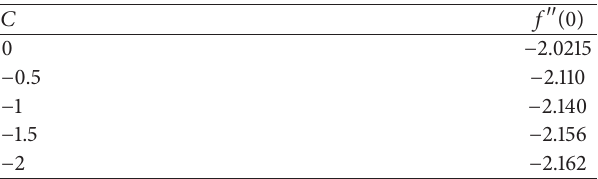
Table 1: Values of 𝑓 󸀠󸀠 (0) for various pressure gradients.